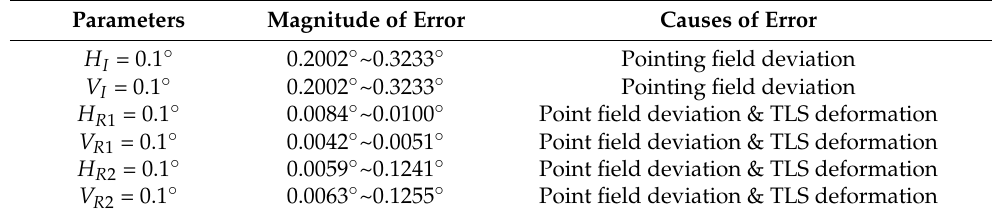
Table 2. The magnitude and causes of the inverse solution error generated by different